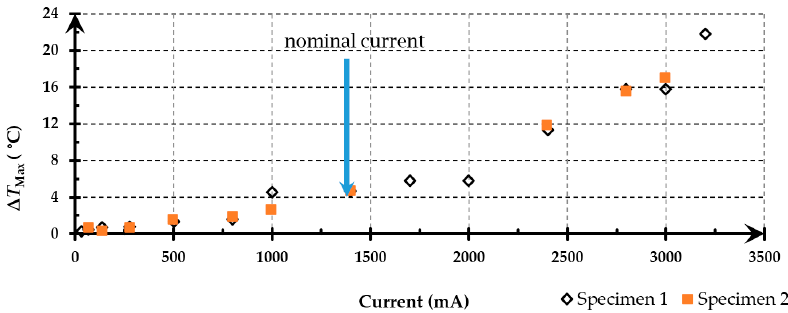
Figure 15. Maximum surface temperature increment ( Δ T Max ) of tested supercapacitor as a function of current.